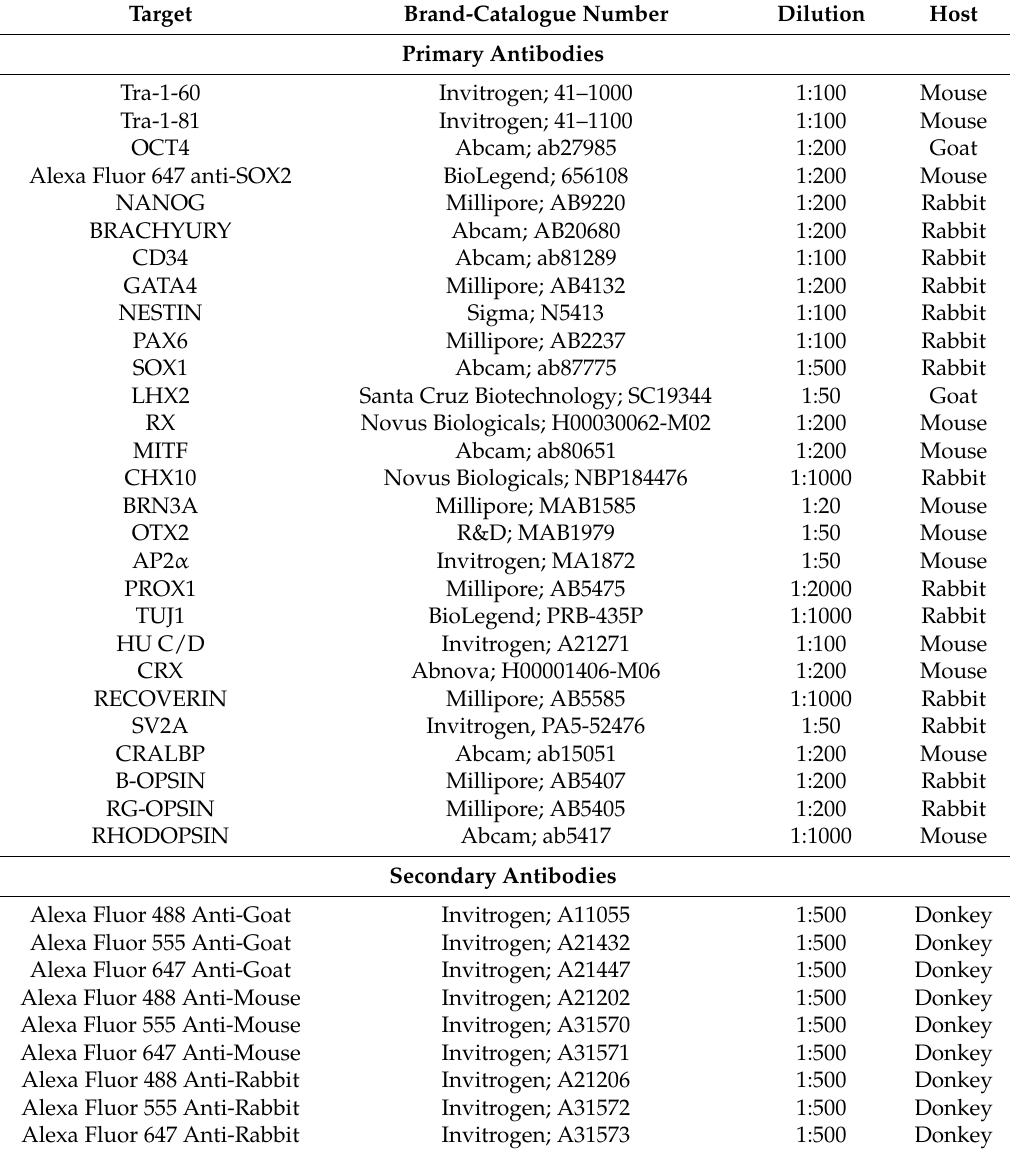
Table 1. List of the primary and secondary antibodies that were used in this